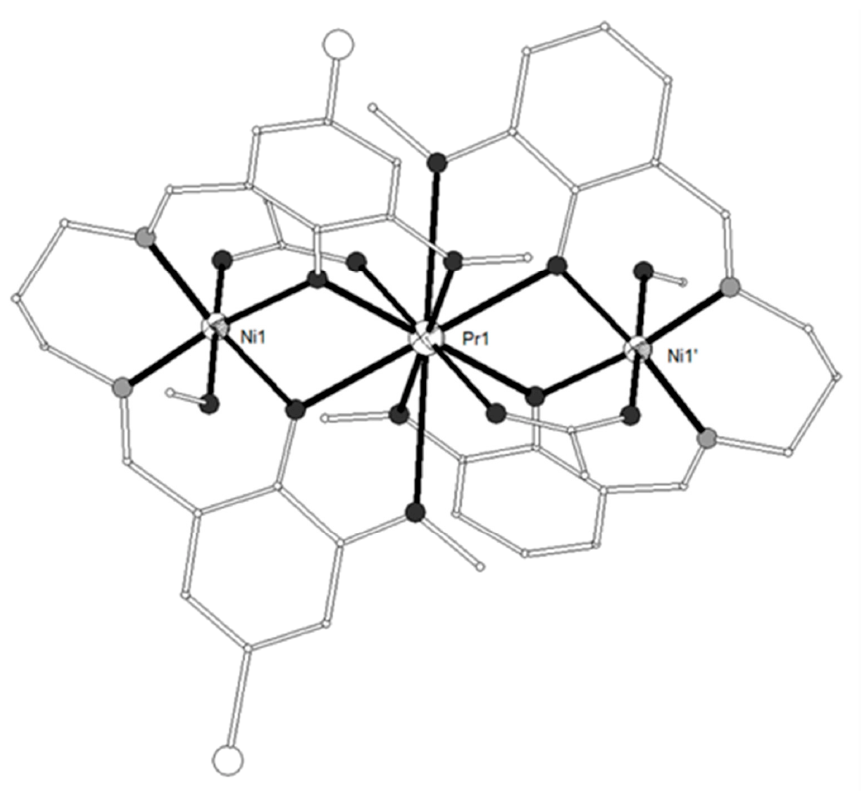
Figure 9. The molecular structure of the cation [(NiL 17 ) 2 Pr(O 2 CMe) 2 (MeOH) 2 ] + in complex 90 . Primed atoms are generated by symmetry: (‘) 1 − x , 1 − y , 1 − z . Color code: Gd large octant, Ni small octant, N light grey, O dark grey, C open small, Br open large [38].